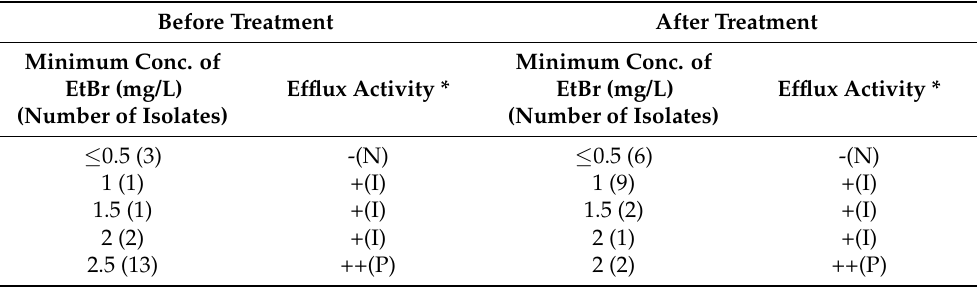
Table 2. The change in efflux activity using the cartwheel method after treatment with CRME. Before Treatment After Treatment Minimum Conc.